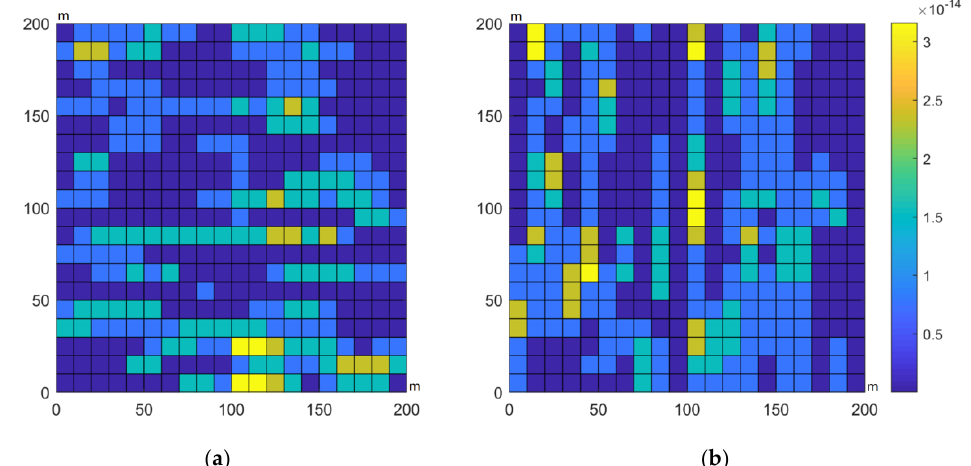
Figure 6. The permeability tensor (mm 2 ) of the FCM model. ( a ) x-x component ( b ) y-y component.